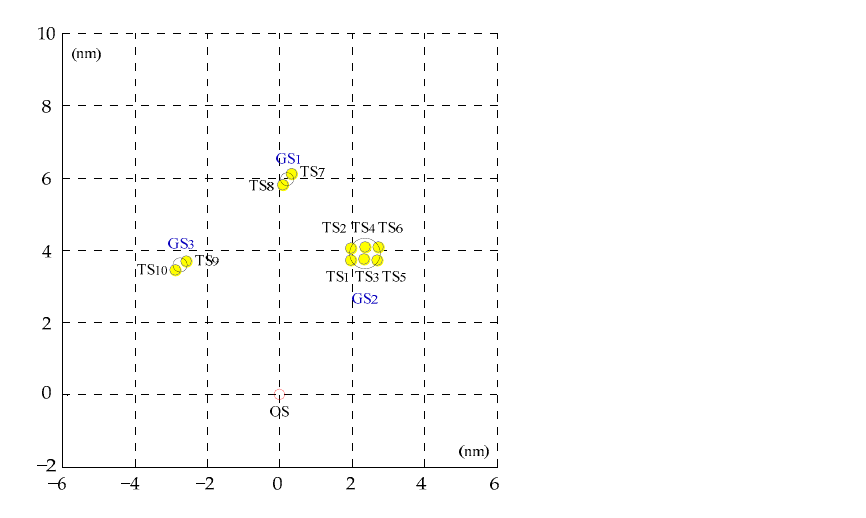
Figure 6. Distribution of target ships and group ships at 0000.